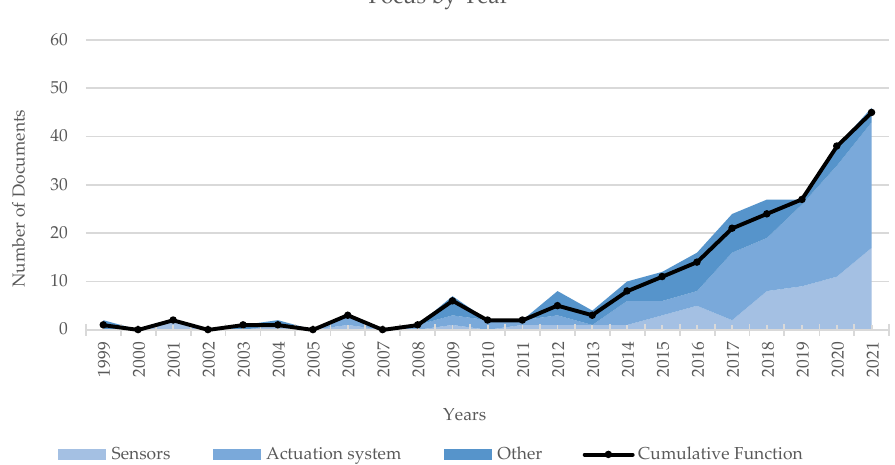
Figure 9. The distribution of the identified documents by year, among categories of the taxonomy by focus. Data include all the occurrences and are presented in stacked format. In the black line with dots is the total amount of documents by